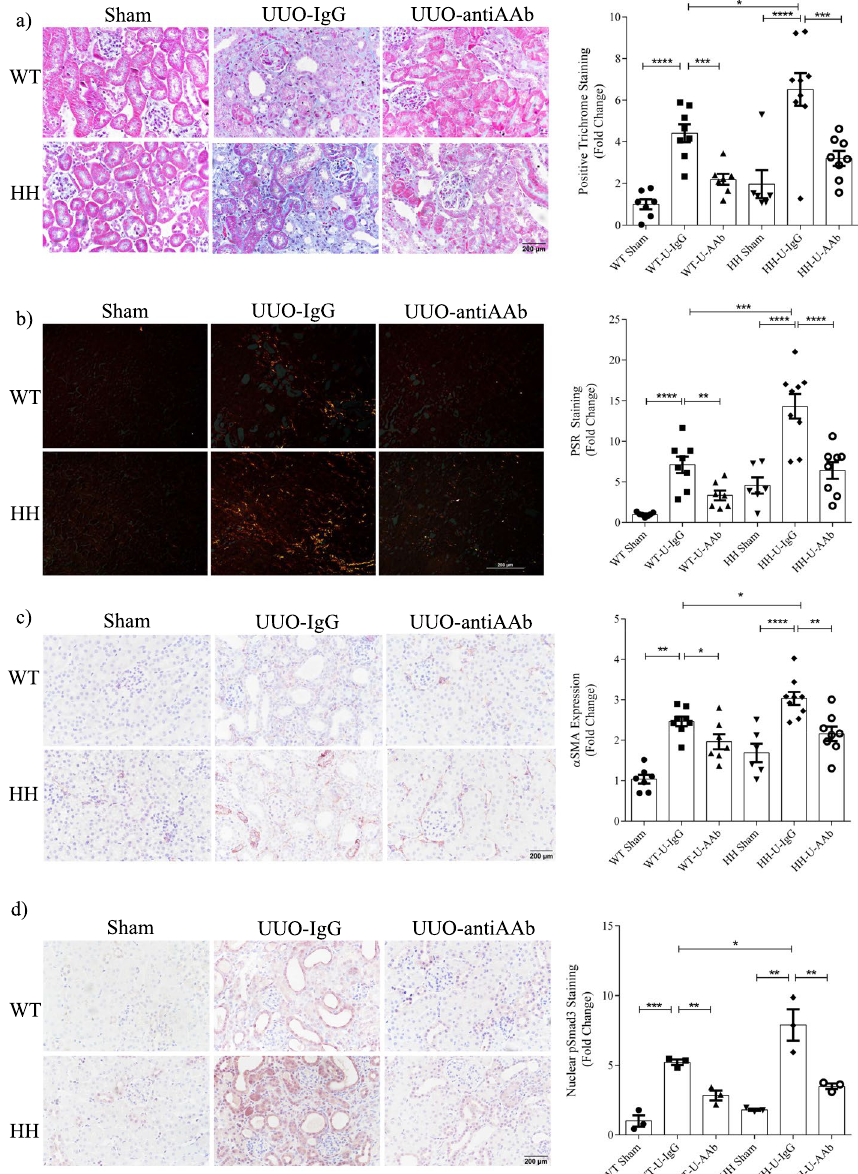
Fig. 7 Augmented fibrosis in UUO by TGFβ1 overexpression is attenuated by actA neutralization. TGFβ1 overexpression worsened UUO-induced fibrosis as assessed by a Trichrome and b PSR. Both were attenuated by actA neutralization. c TGFβ1 overexpression augmented UUO-induced expression of the fibroblast marker αSMA, which was attenuated by actA inhibition. d Nuclear levels of phosphorylated Smad3 were also augmented by TGFβ1 overexpression after UUO and this was inhibited by actA neutralization (n ***, **** P < 0.05, 0.01, 0.001, 0.0001; one-way ANOVA with Tukey’s multiple comparisons post hoc